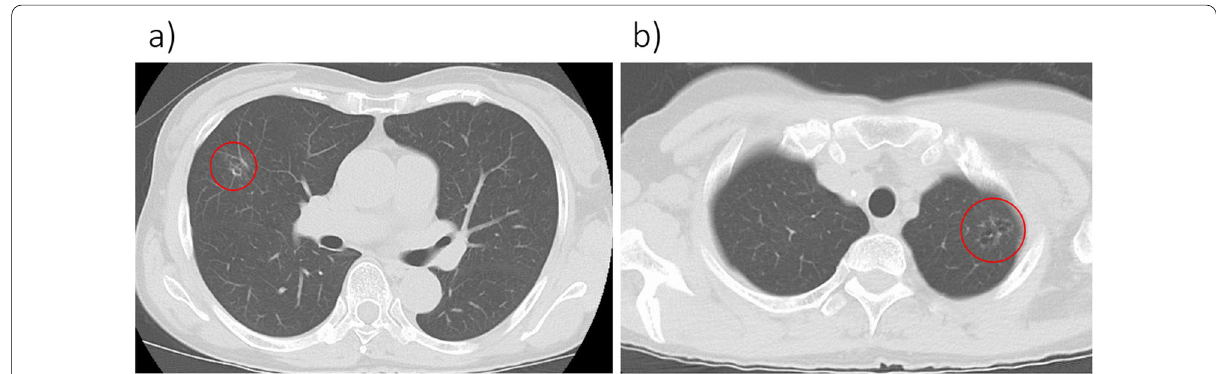
Fig. 1 Computed tomography findings of the lung tumor. a A frosted glass shadow is observed in the middle lobe of the right lung. b A frosted glass shadow is observed in the upper lobe of the left